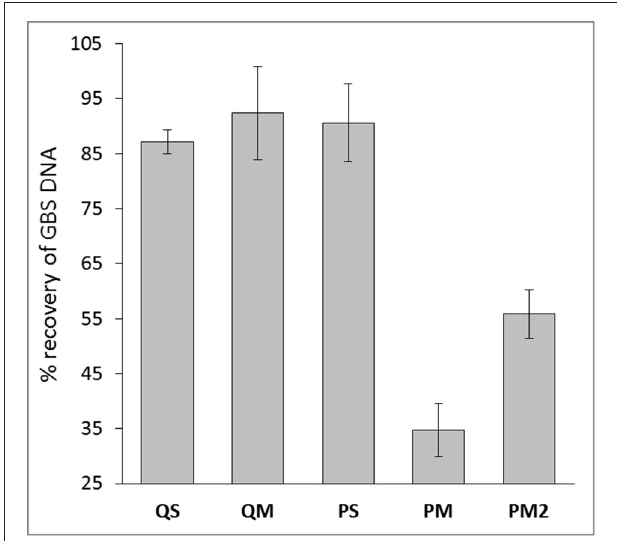
FIGURE 4 | Relative abundance of OTUs in meconium samples ( n = 5) after extraction with various kits at phylum level.